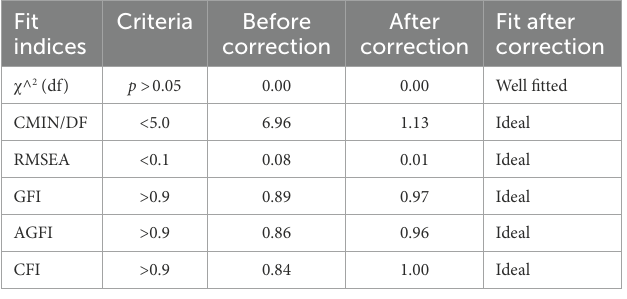
TABLE 4 Bollen-Stine bootstrap revised estimates.